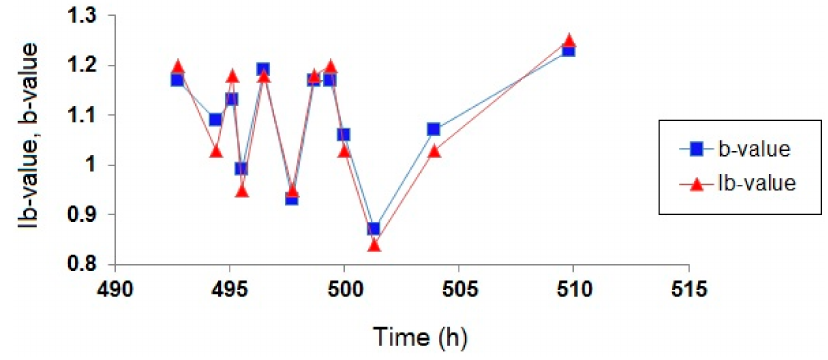
Figure 5. The b -value and Ib -value calculated using groups of 300 numbers of